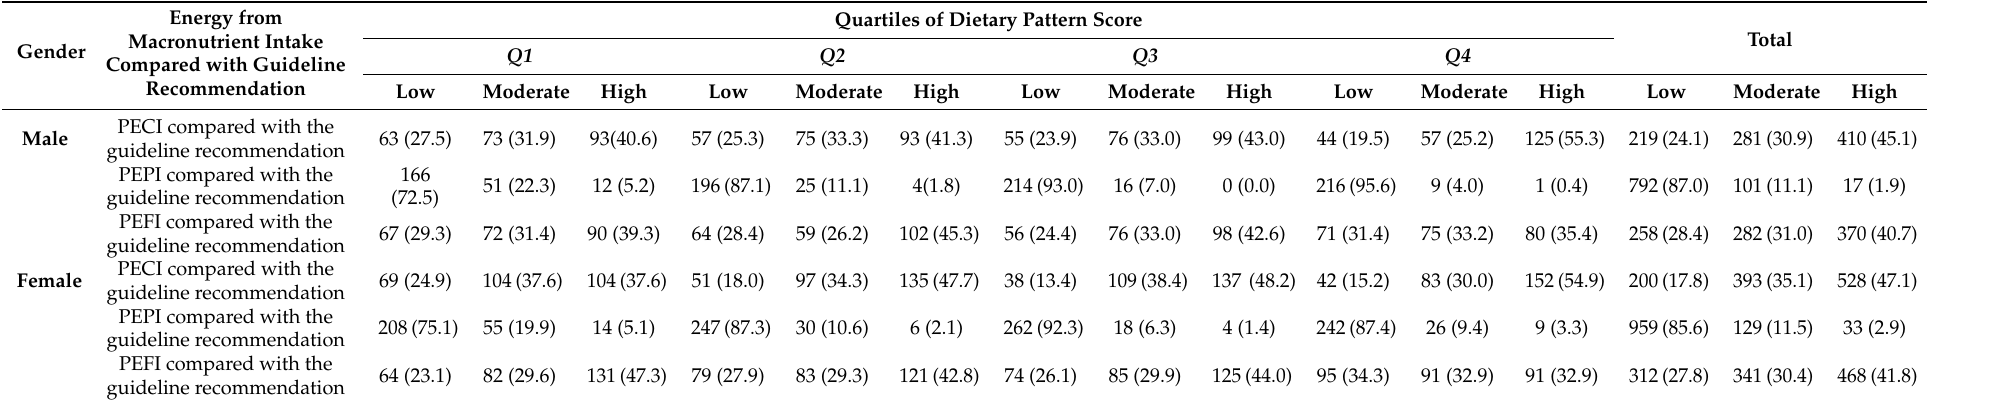
PECI: Percentage of energy from carbohydrate intake; PEPI: Percentage of energy from protein intake; PEFI: Percentage of energy from fat